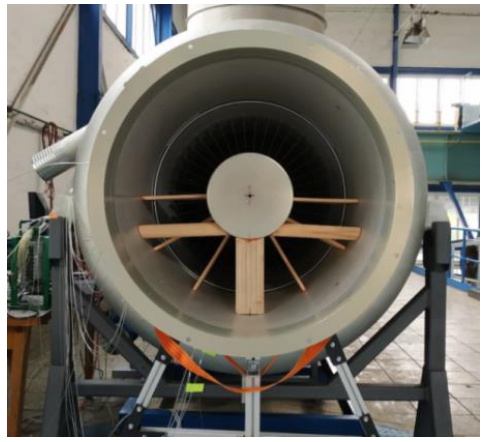
Fig. 14. Comparison of pressure recovery coefficient values.